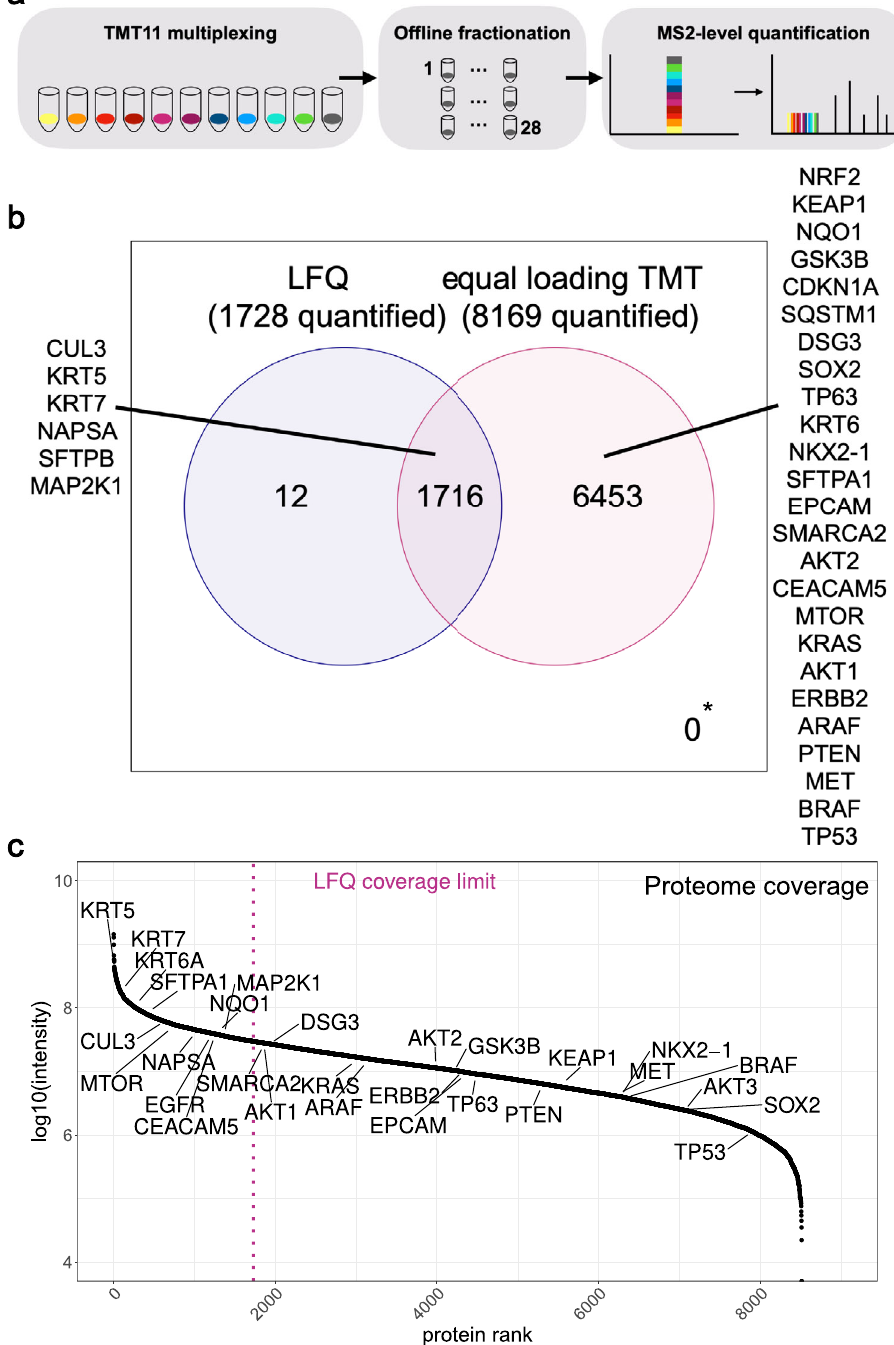
Fig. 2 Deep FFPE proteome coverage with TMT11 labeling and two-dimensional liquid chromatography. a TMT multiplexing combined with high pH of fl ine fractionation allows for deeper LC-MS/MS coverage while spending less measuring time per individual sample. Multiplexed, TMT-labeled peptide samples are loaded in equal total quantities per TMT-channel and fractionated via two dimensions of liquid chromatography before MS analysis. Increased MS time requirements per TMT experiment for 28 injections are compensated here by multiplexed analysis of up to 11 samples. b Venn diagram showing the overlap of quanti fi ed proteins from LFQ and equal loading TMT quanti fi cation. NSCLC-relevant markers are shown as quality control. Only unique proteins and no isoforms were counted as quanti fi ed proteins. * marks proteins only identi fi ed but not quanti fi ed with either method (0). c Log10 reporter ion intensity distribution over all proteins that were quanti fi ed in equal loading TMT. The LFQ coverage limit is shown in